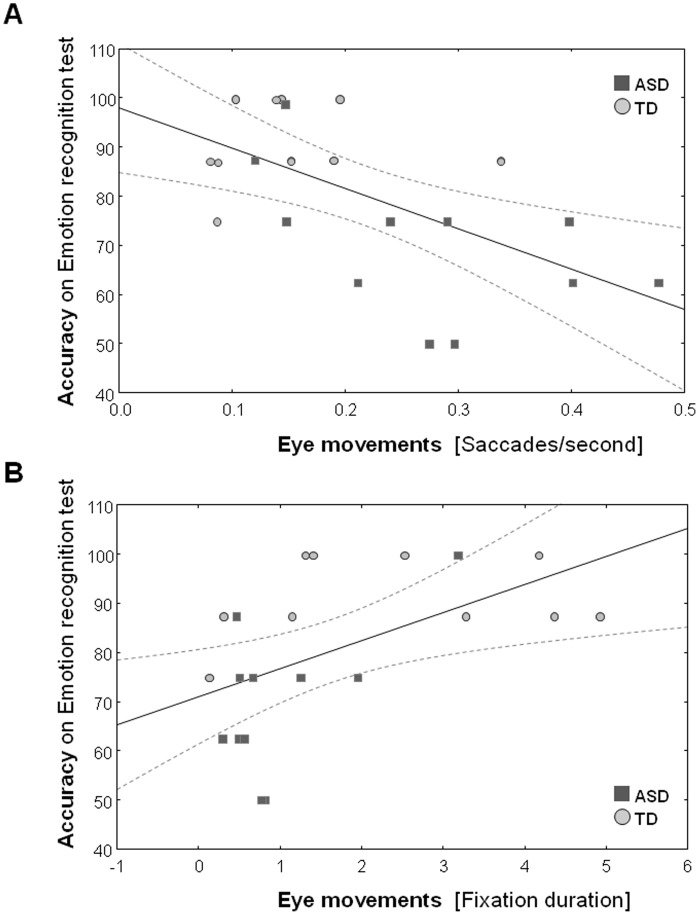
Across all participants,
figure 4
 displays the linear fits for the relationship between accuracy on the Emotion recognition test (y-axis) and eye movements (x-axis) (saccades/second (A); fixation duration (B)).Dotted lines denote 0.95 confidence intervals.